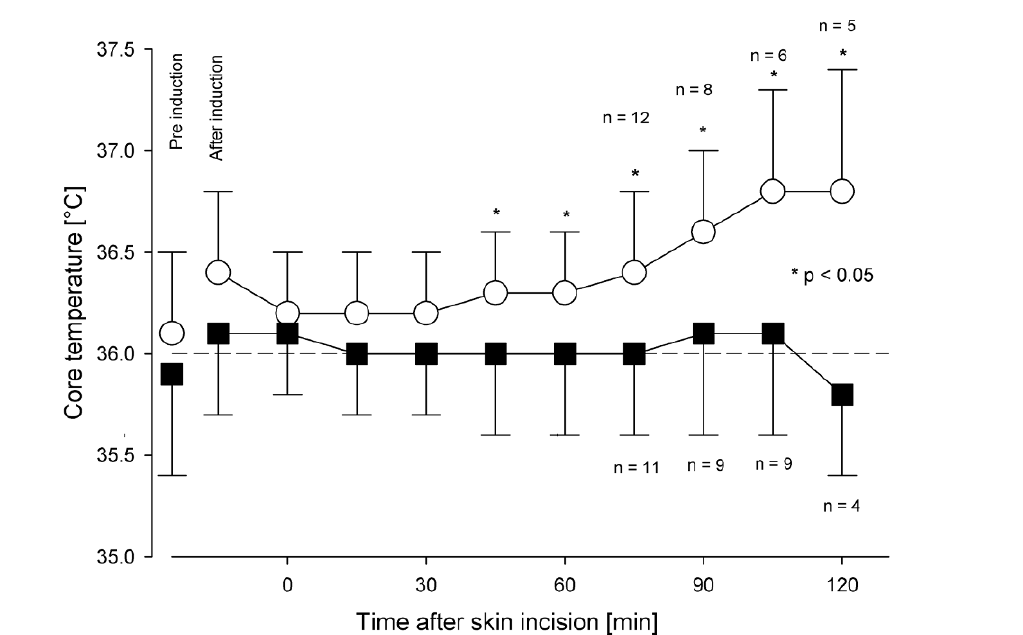
Figure 2. Mean pre- and intraoperative temperatures of the treatment group (o) and control group ([]). Error bars represent SD. In each group, data were complete for at least sixty minutes (n =